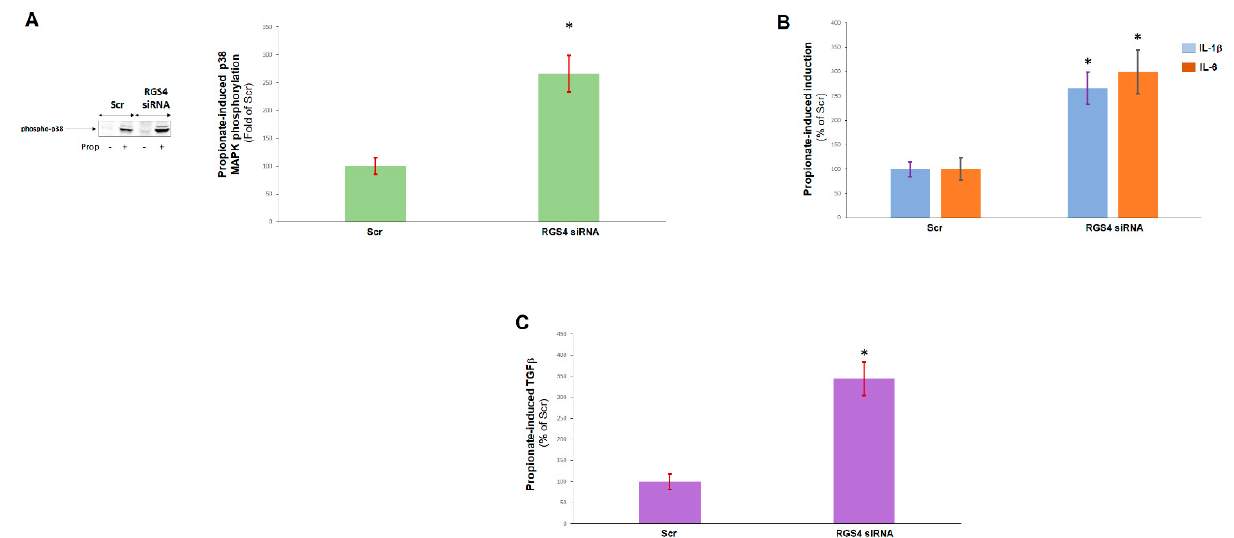
Figure 2. RGS4 and FFAR3 signaling in cardiac myocytes. ( A ) A 1 mM propionate-induced p38 MAPK phosphorylation/activation in the control (scrambled siRNA-transfected, Scr) or in RGS4- depleted (RGS4 siRNA) H9c2 cells. A representative blot is shown on the left and the densitometric quantitation on the right. Prop: Propionate. * , p < 0.05; n = 3 independent experiments performed in triplicate. ( B , C ) A 1 mM propionate-induced IL-1 β and IL-6 ( B ) or TGF- β 1 ( C ) protein synthesis in these cells. * , p < 0.05, vs. respective Scr; n = 3 independent measurements per condition per cell clone.